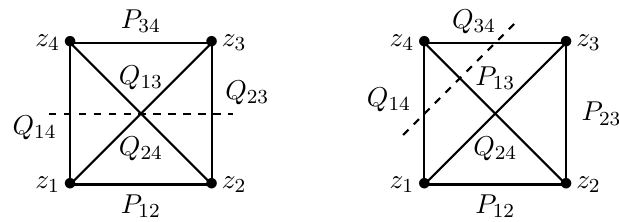
Figure 4 . In the framework of non-planar A -cycle graph functions, the two types of propagators Q ij and P ij are represented by edges (drawn as solid lines) which do and do not cross the dashed line, respectively. Said dashed line tracks the distribution of the punctures in non-planar open- string amplitudes over two cylinder boundaries. The situations for the non-planar integrals M open and M open are depicted in the left and right panel, 123 j 4